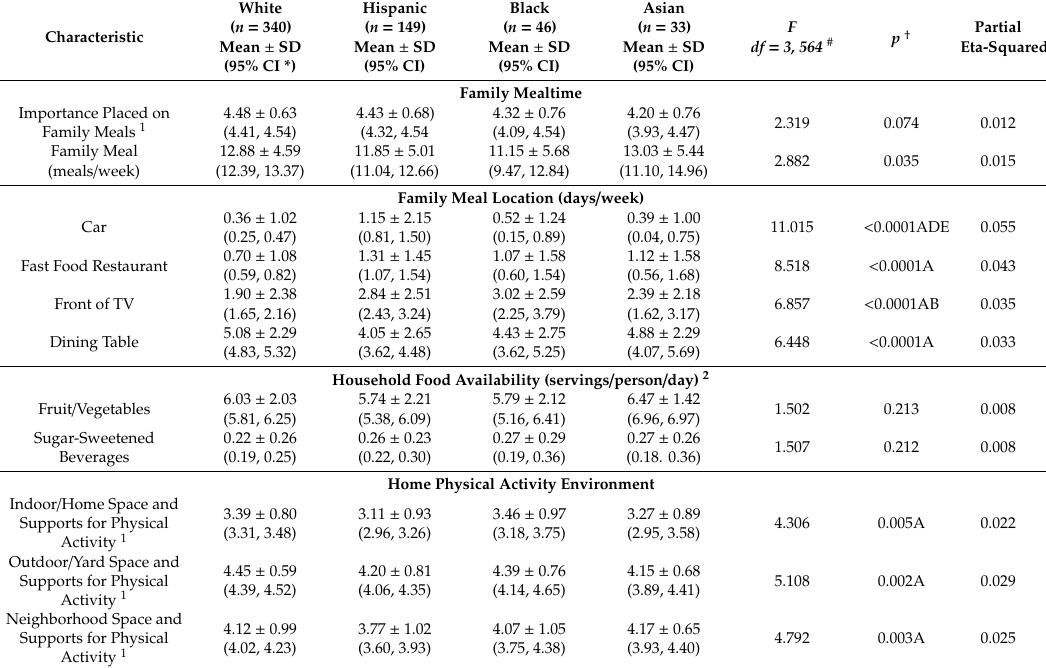
Table 4. Home Environment Characteristics by Maternal Race / Ethnicity ( N =